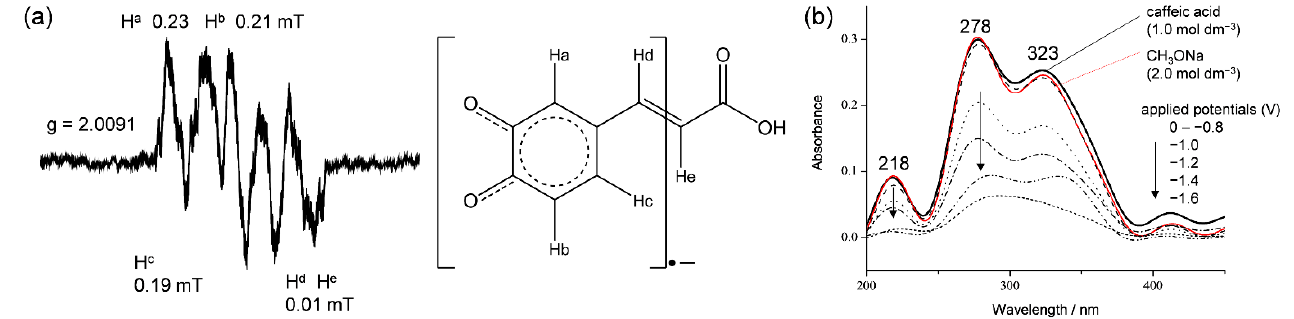
Figure 3. ( a ) ESR and ( b ) UV–vis spectra of a O 2 /O 2• − solution exposed to CafH 2 (COOH) in DMF under an applied potential of − 1.3 V vs. Fc + /Fc.